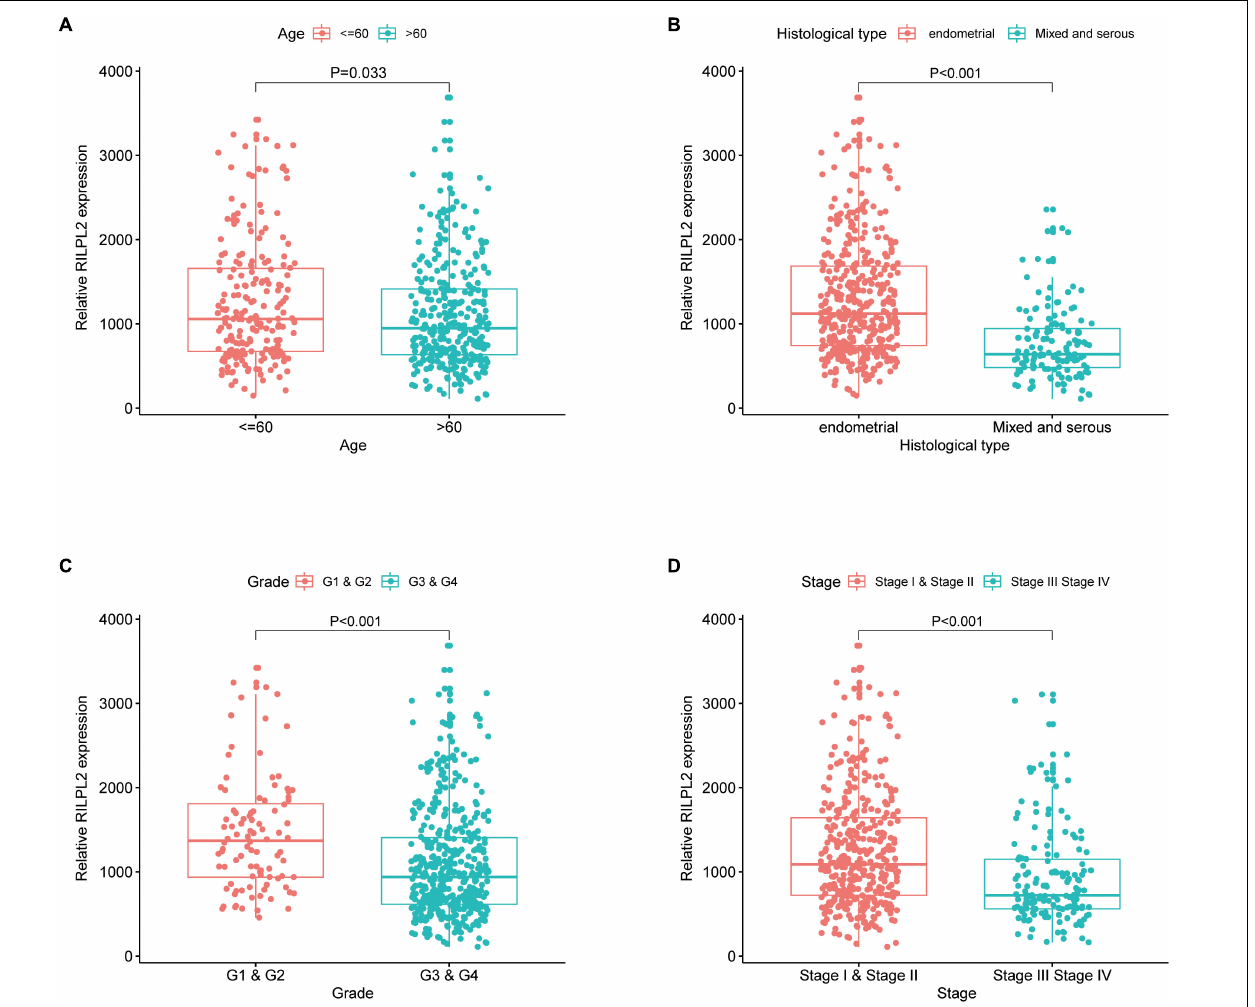
FIGURE 2 | Correlation of RILPL2 expression of and clinicopathologic variables. (A) age, (B) histological type, (C) grade, and (D) stage.